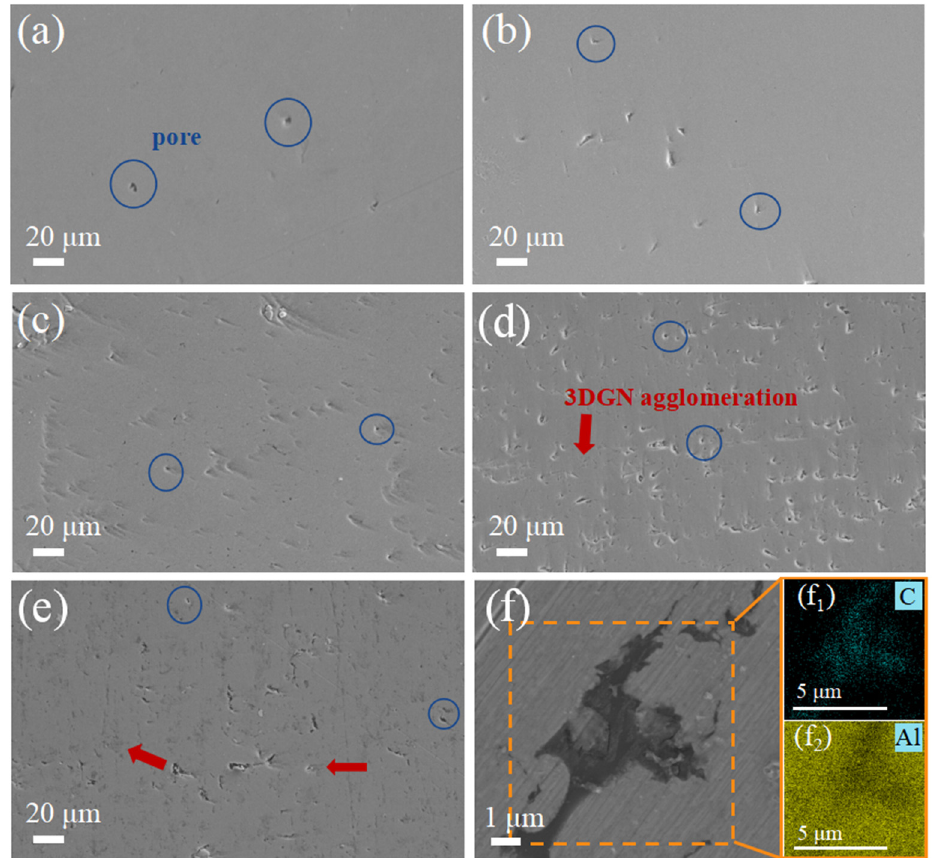
Figure 5. SEM images of ( a ) sintered pure Al sample, ( b ) sintered 0.075% ‐ 3DGN/Al composites, ( c ) sintered 0.150% ‐ 3DGN/Al composites, ( d ) sintered 0.225% ‐ 3DGN/Al composites, and ( e ) sintered 0.300% ‐ 3DGN/Al composites. ( f ), ( f 1 , f 2 ) EDS mapping analysis images of the sintered 0.300% ‐ 3DGN/Al composites. The blue circles and red arrows indicate the pore and 3DGN agglomeration, respectively.